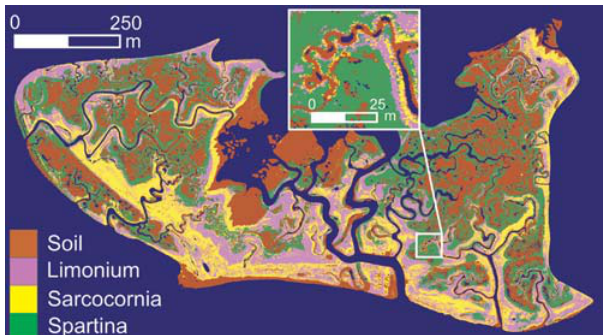
Figure 1. Vegetation map of the San Felice salt marsh in the Venice Lagoon (geometric resolution is 0.5 m, channels and creeks are in blue). The inset provides an indication of the high level of detail characterizing the data, which resolve small-scale channel and vegetation structures.